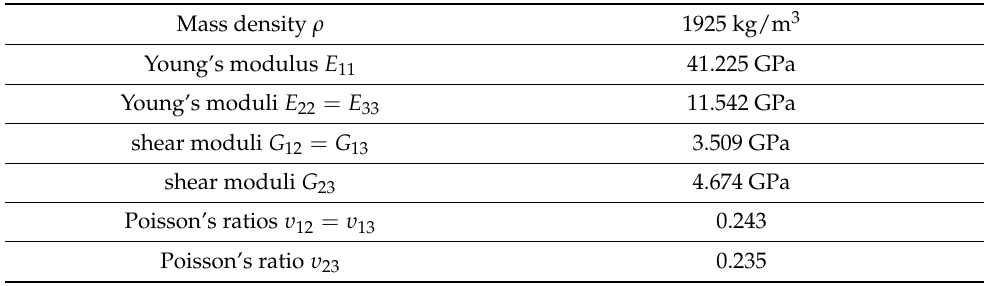
Table 2. Main mechanical properties of the composite sleeve material; local coordinate systems highlighted in Figure 5.